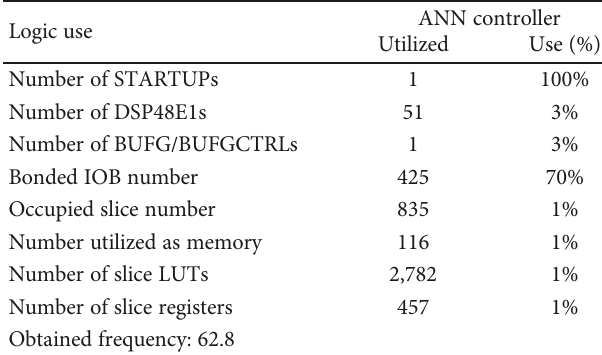
Table 8: Characteristics of FPGA Virtex-6-XC6VLX315T [30]. Logic cells